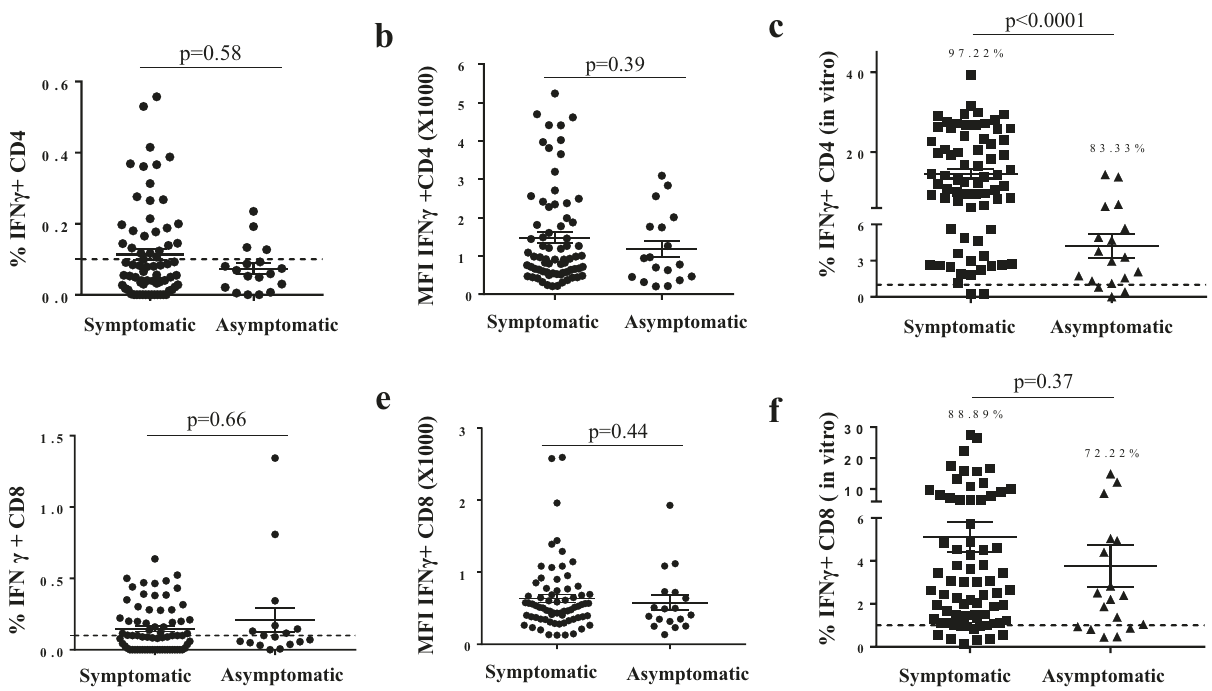
Fig. 3 Comparisons of the T cell memory and in vitro expansion of SARS-CoV-2 speci fi c T cells between symptomatic and asymptomatic COVID-19 patients. a , d Frequencies of IFN γ expressing cells in CD4 + ( a ) and CD8 + ( d ) T cells in recovered symptomatic ( n = 71) and asymptomatic ( n = 18) COVID-19 patients ex vivo. b , e MFI of IFN γ staining in CD4 + ( b ) and CD8 + ( e ) T cells from symptomatic and asymptomatic COVID-19 patients. c , f Frequencies of IFN γ expressing ( c ) CD4 + and ( f ) CD8 + T cells after in vitro expansion in symptomatic ( n = 72) and asymptomatic ( n = 18) COVID-19 patients. Percentages shown are the frequencies above the cut off (1%, which was the upper limit observed in no-peptide control stimulations). Error bars represent mean ± SEM. The student ’ s t test was performed with two-sided p values